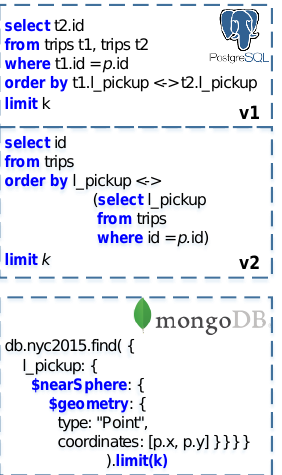
Figure 2 k NN queries in Postgres (v1 and v2) and MongoDB In all of the aforementioned distance calculations, the shortest distance between two points on the earth is calculated. Sphere and ellipsoid are the most suitable geometric shapes to represent the earth mathematically. Haversine and Vincenty distance functions could be used to calculate the distance between two points, where the coordinates are represented in geographical projection system (i.e. latitude and longitude).